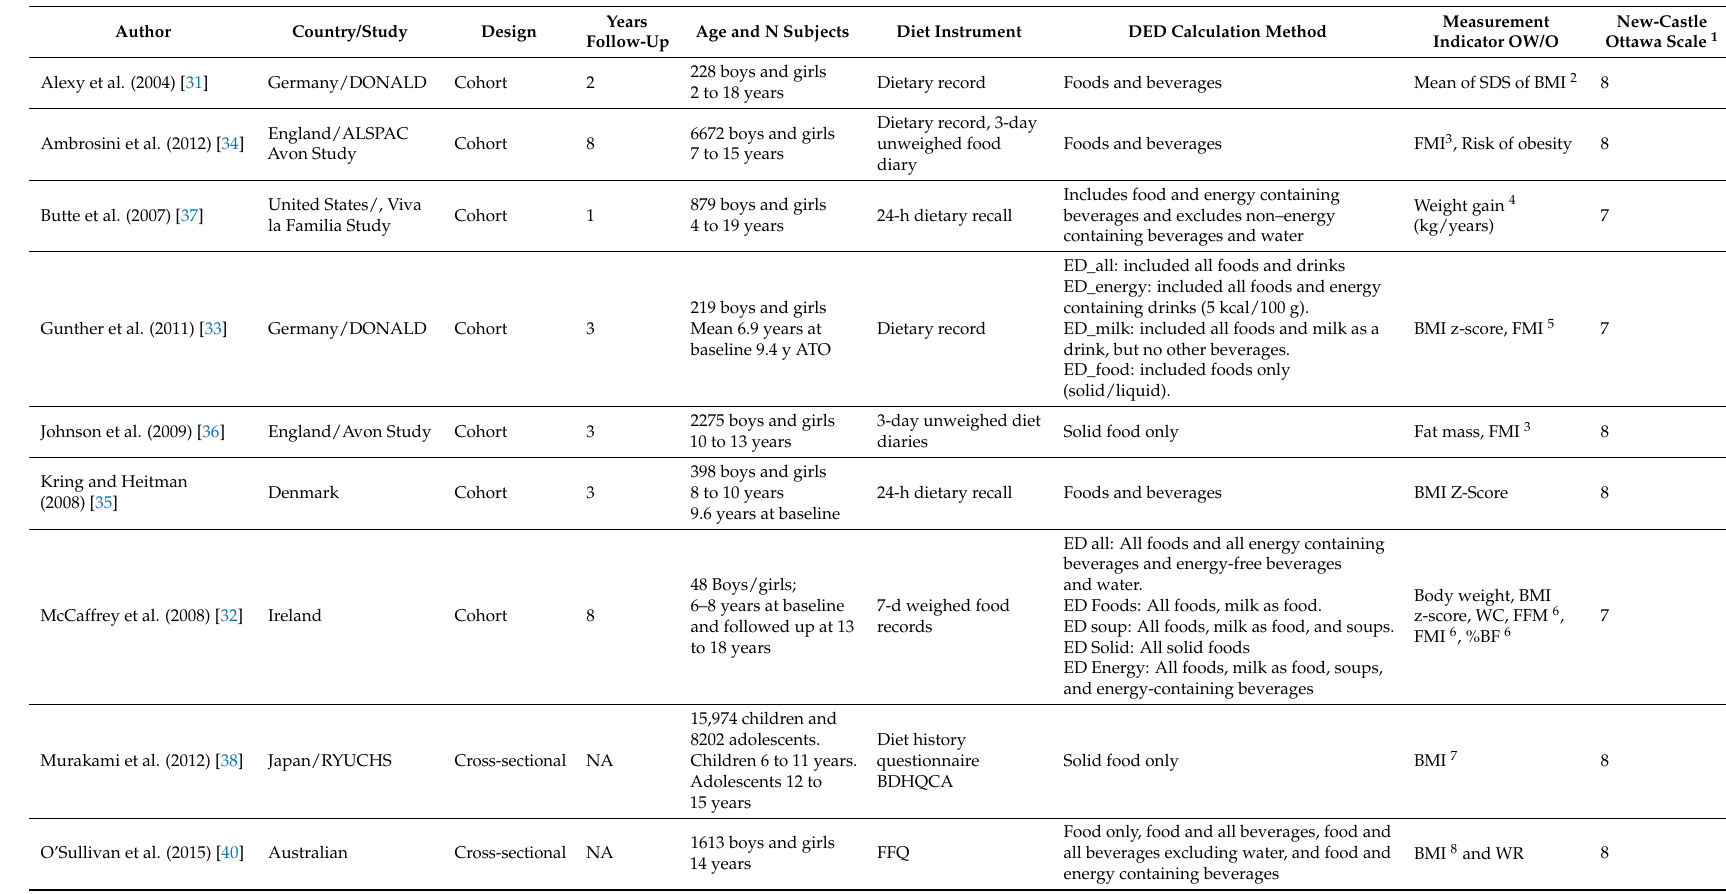
Table 1. Characteristics of the eligible studies